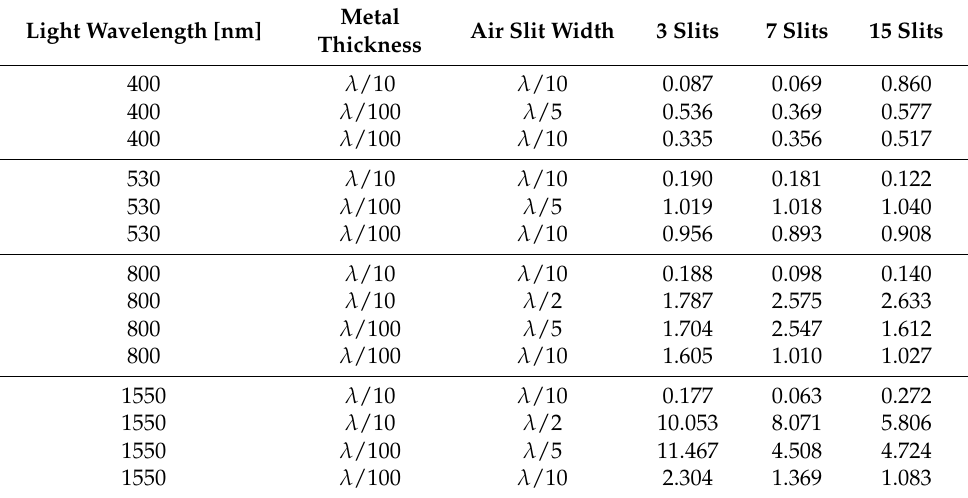
Table 2. Maximum absolute values of the normalized electric field along the intrinsic region. Metal Air Slit Light Wavelength [nm] Thickness